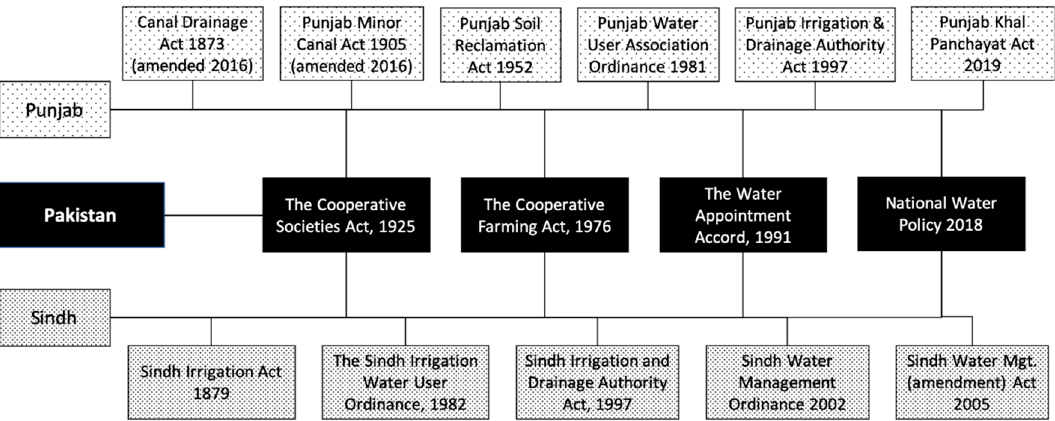
Figure 2. Irrigation policy and legislation in Pakistan. Source: Authors.